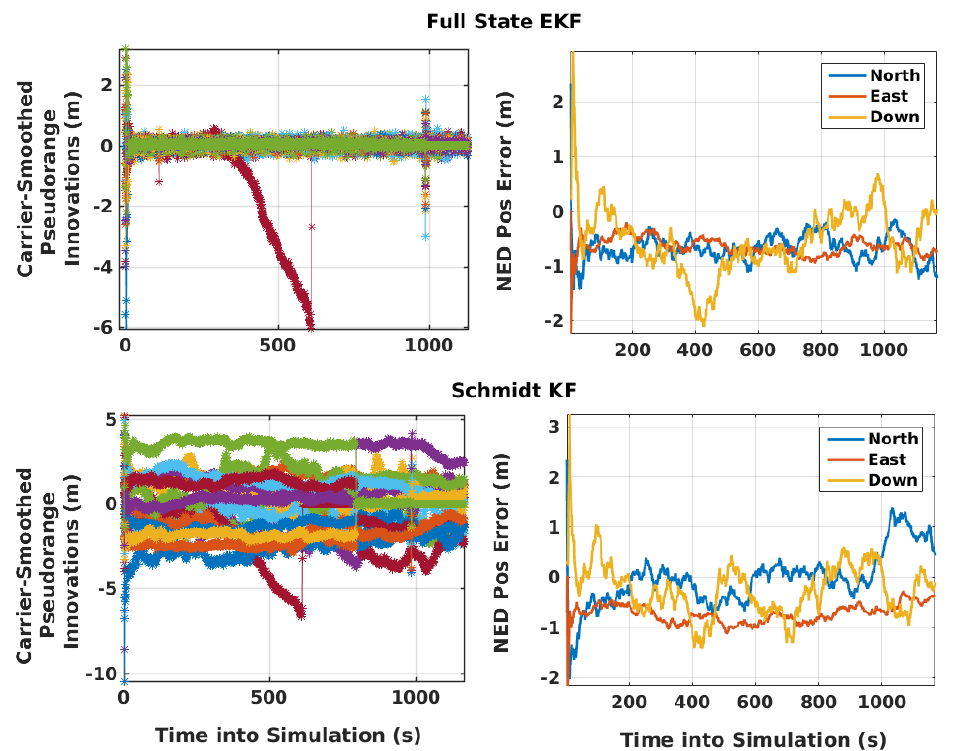
Figure 7. EKF and SKF carrier smoothed-pseudorange measurement innovations and position estimation errors in the NED frame. The ramp error in innovations is due to a low elevation satellite below the mask angle, which is not considered for